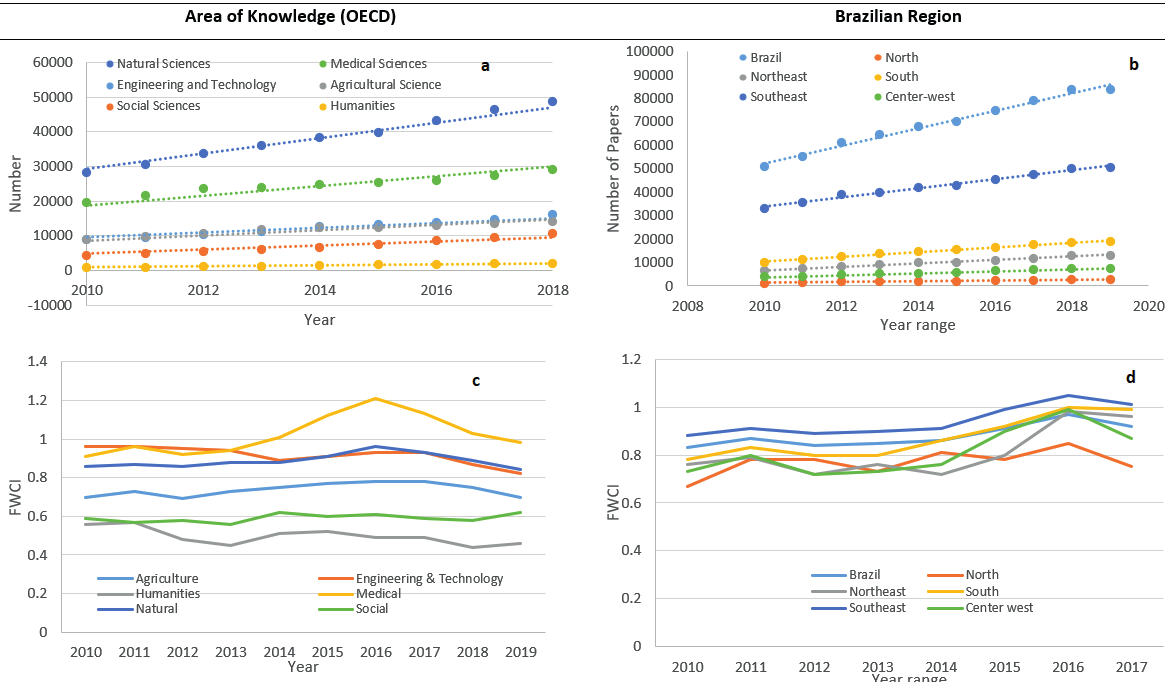
Figure 2. Number of Brazilian documents in Scopus® from 2010 to 2019 by knowledge area (a) and region (b) of the country and Field Weighted Citation Index (FWCI) by knowledge area (c) and region (d) of the country. (All R 2 >0.93 for